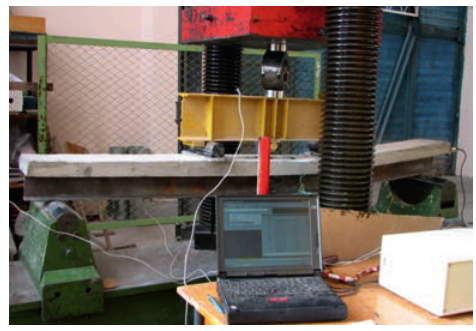
Fig. 7. General view of the set-up for the test of the beams